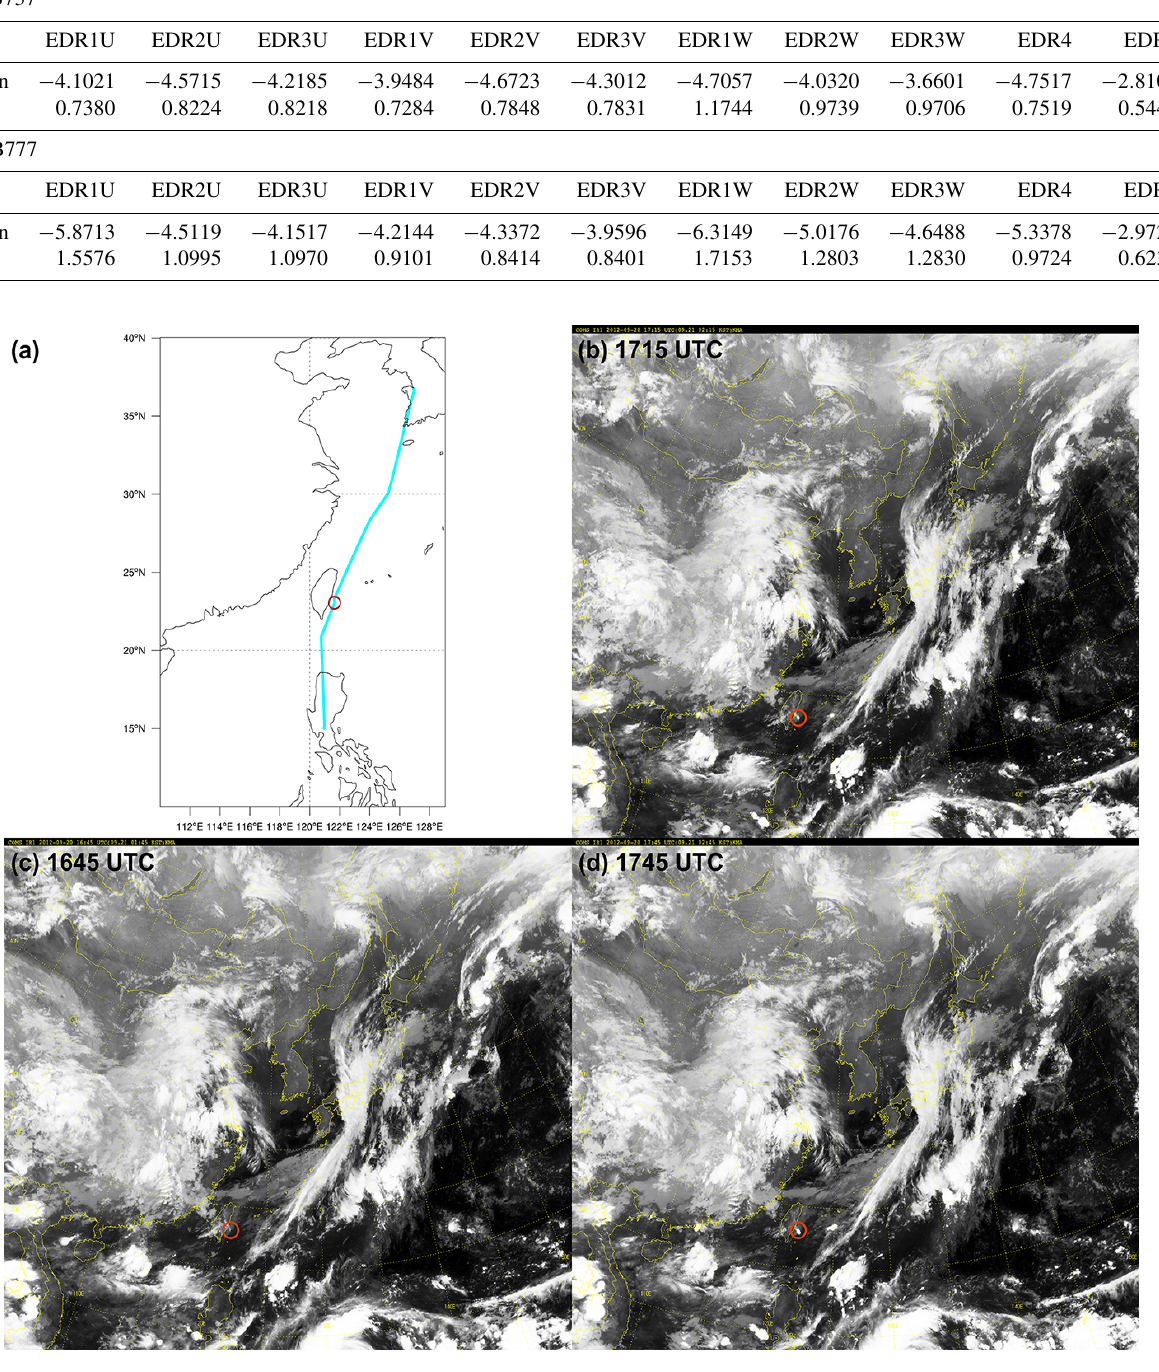
Figure 10. (a) The flight route (line) from 16:13 to 19:10UTC on 20 September, IR image obtained from the COMS at (b) 17:15UTC when the turbulence was encountered, (c) 16:45UTC before the incident time, and (d) 17:45UTC after the incident time. The horizontal location of the turbulence encounter is represented by a